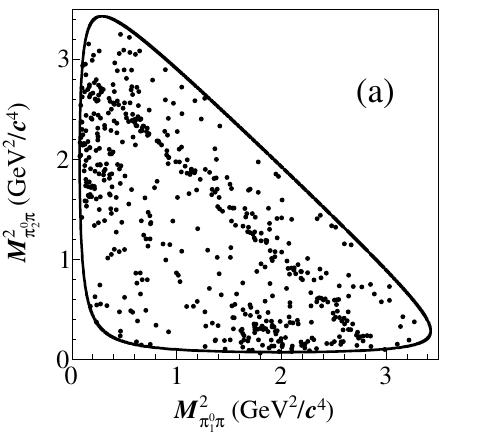
versus M 2 for (a) the data sample and (b) the inclusive π + π 0 π + π 0 √ s = 4 . 178 - 4 . 226 GeV,